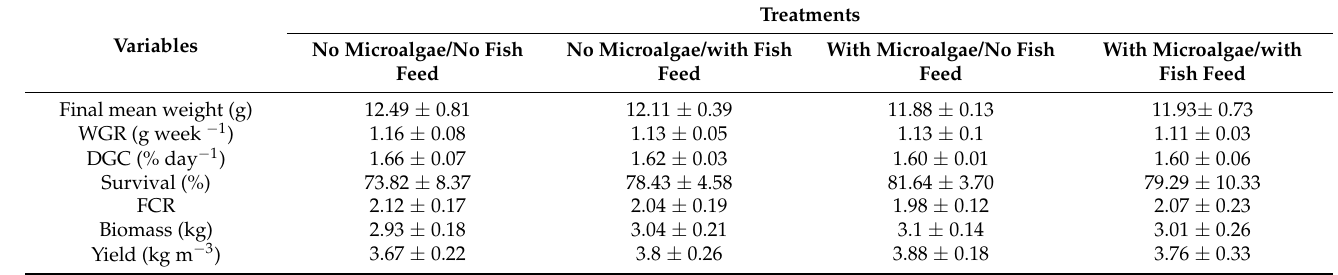
Table 2. Pacific White shrimp ( Litopenaeus vannamei ) growth performance when reared in integration with Nile tilapia ( Oreochromis niloticus ) using biofloc technology for 62 days, evaluating the addition of microalgae and fish feed in a factorial